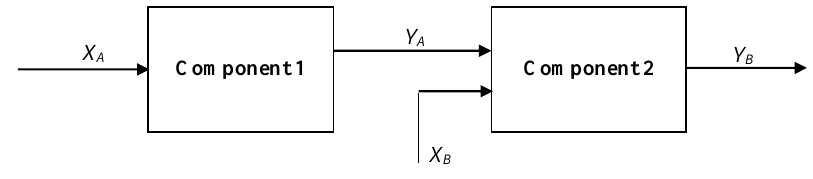
Figure 1. Supply chain with two components [31].